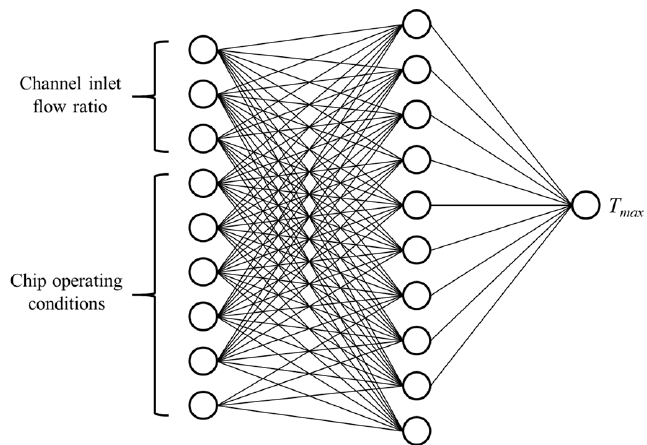
Figure 7. Schematic diagram of neural network configuration. Figure 8a shows the scatter plot of the target output and the prediction output. The correlation coefficient between the target output and all 1494 samples was 0.99327. Figure 8b shows the comparison between the expected output and predicted output of the neural network under 100 different chip operating conditions in the test dataset.